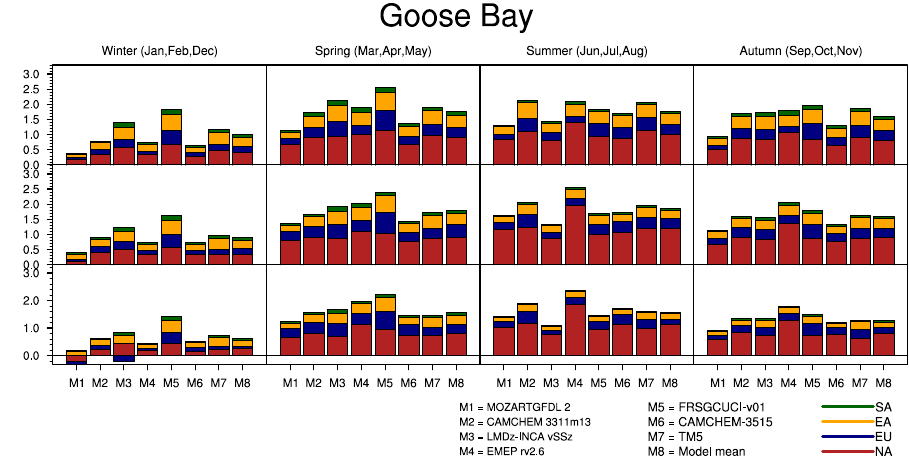
Fig. 17: Effects above Goose Bay on O 3 (ppb) of 20% reductions in emissions in the four source regions in winter, spring, summer and autumn calculated with the first seven models (and the model mean) listed in Table 1 (see legend above). Results are aggregated to LT (900 - 700hPa), MT (700 - 500hPa) and UT (500 - 300hPa).